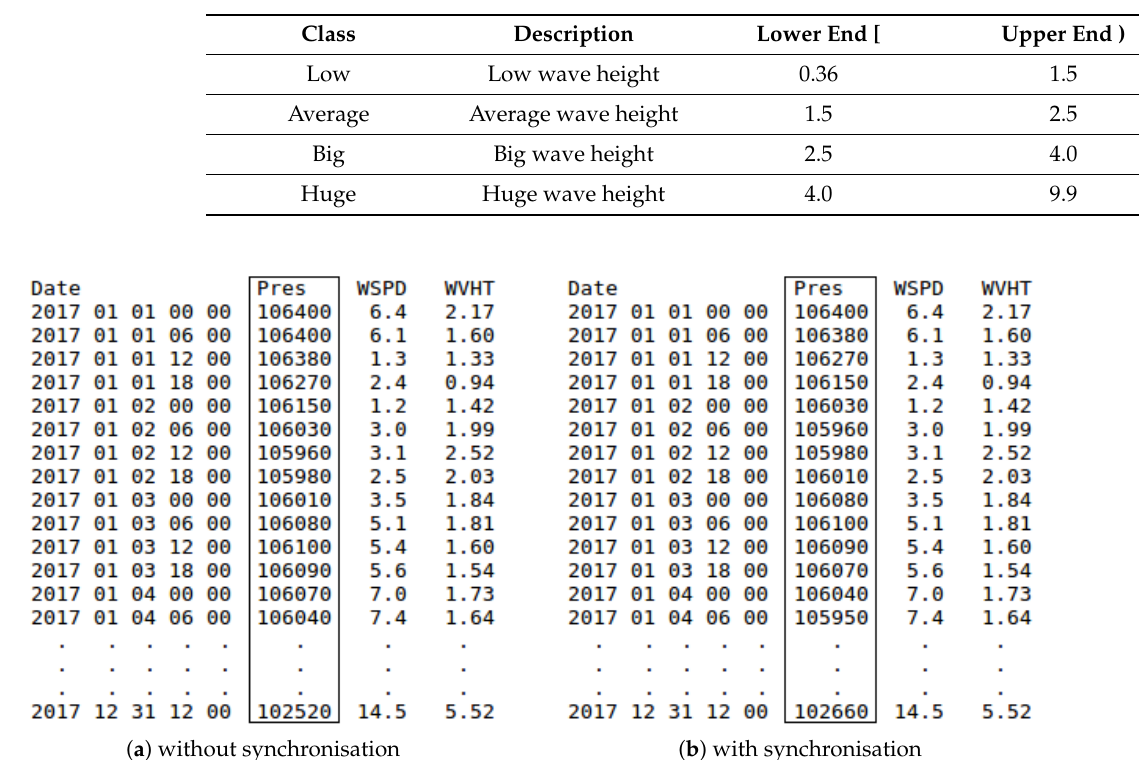
Table 2. Thresholds for the classification example represented in Figure 10.